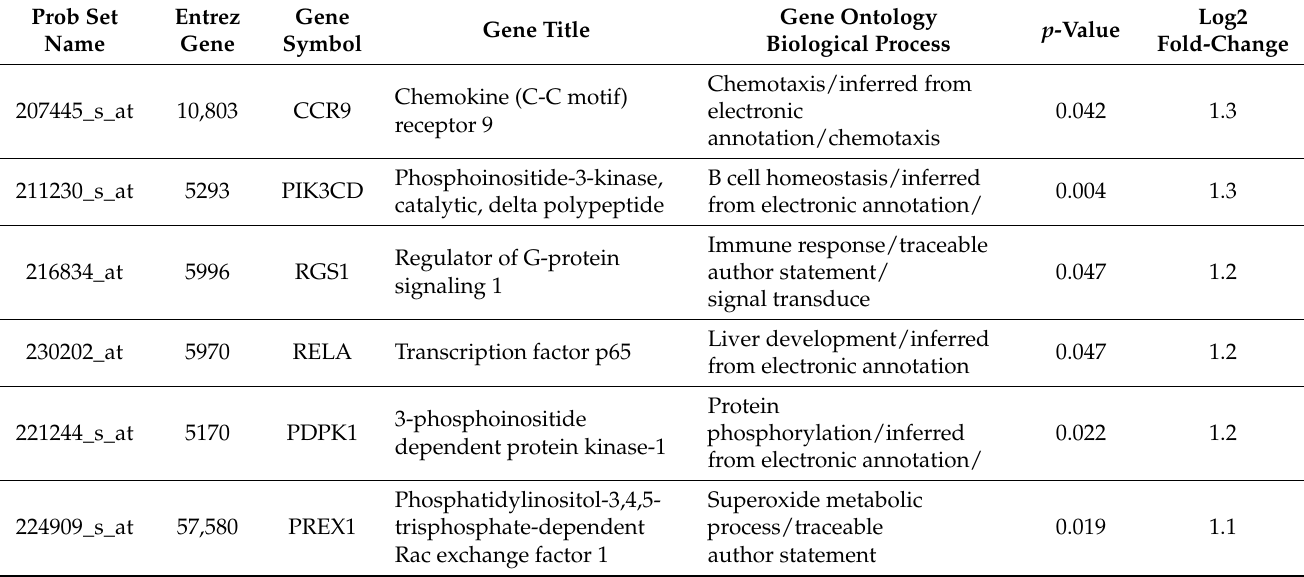
Table 5. Differential expression of 33 transcripts based on fold change annotated to genes that are involved in inflammation mediated by chemokine and cytokine signaling pathway (High magnesium